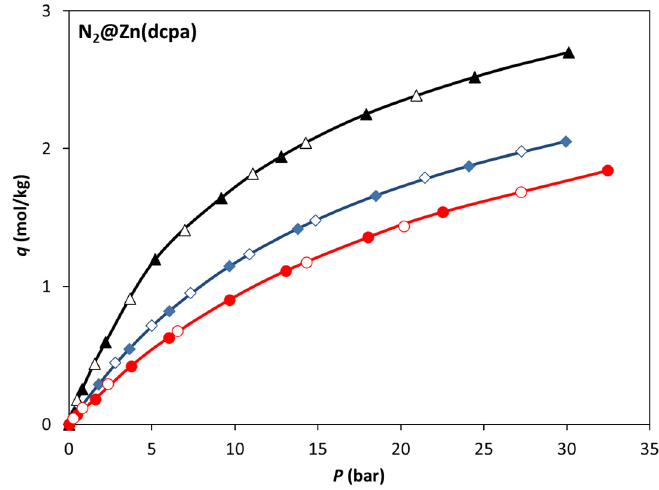
Figure 7. Absolute adsorption equilibrium isotherms of N 2 on Zn(dcpa) at 273 K ( ▲ ), 303 K ( ♦ ), and 323 K ( • ). Filled and empty symbols represent adsorption and desorption experimental data, re- spectively.